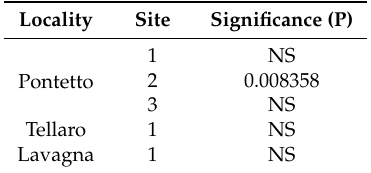
Figure 9. Rebound ( R ) values related to Chthamalus spp. covers on different localities. ( a ) Tellaro locality; ( b ) Pontetto locality; ( c ) Lavagna locality; and ( d ) comparison between Verrucaria and Chthamalus spp. in Tellaro locality.